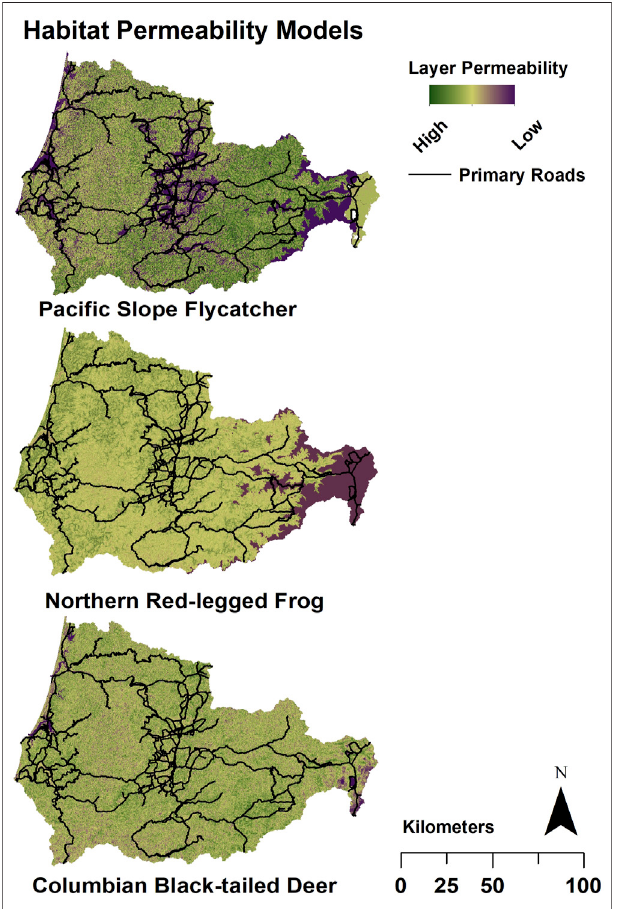
FIGURE 3 | Example Habitat Permeability Models for Paci fi c slope fl ycatcher, northern red-legged frog, and Columbian black-tailed deer. The primaryroads(blacklines)aresuperimposedonthemodelforreference.Plum indicates the lowest permeability of each 30 m grid cell; yellow indicates moderate permeability, and green indicates high permeability. The inverse of the permeability models was used as the resistance layers in Omniscape.